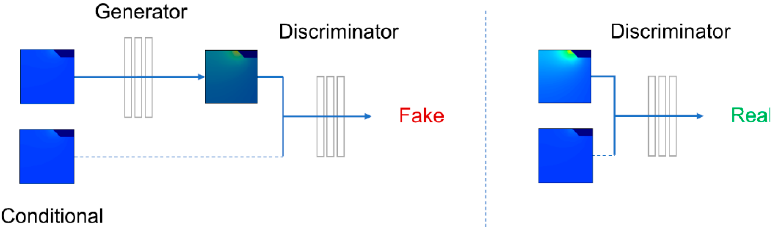
Figure 3. Training and testing flowchart of deep learning model, a conditional variant of Generate adversarial network (GAN) on top of the CNN backbones was adopted to capture the nuanced variations during the heat process.